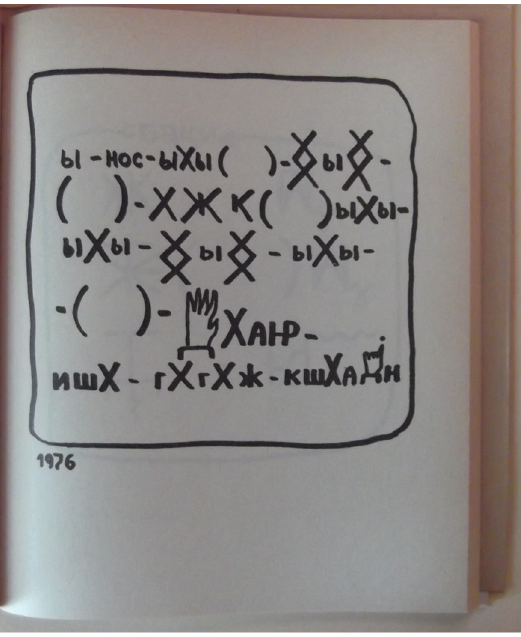
Figure 8. Page from ‘Sobukvy’.